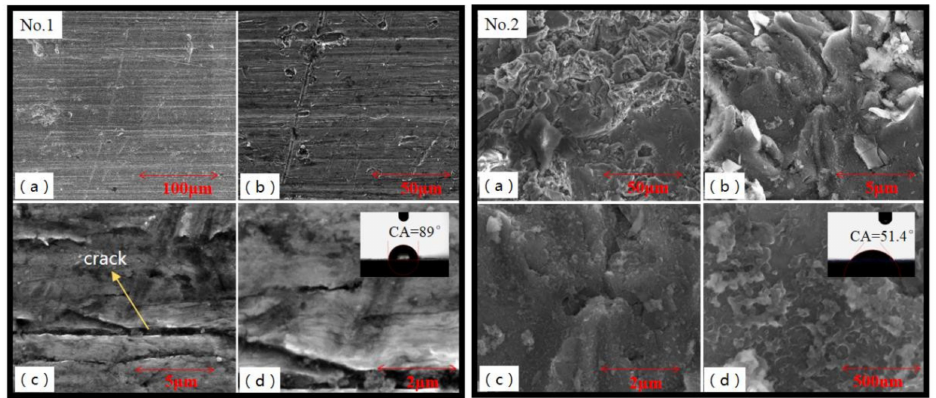
Figure 5. SEM images showing details of surface structure of No.1 sample (untreated) and No.2 sample (sandblasted). Form ( a – d ), the image magnification were monotone